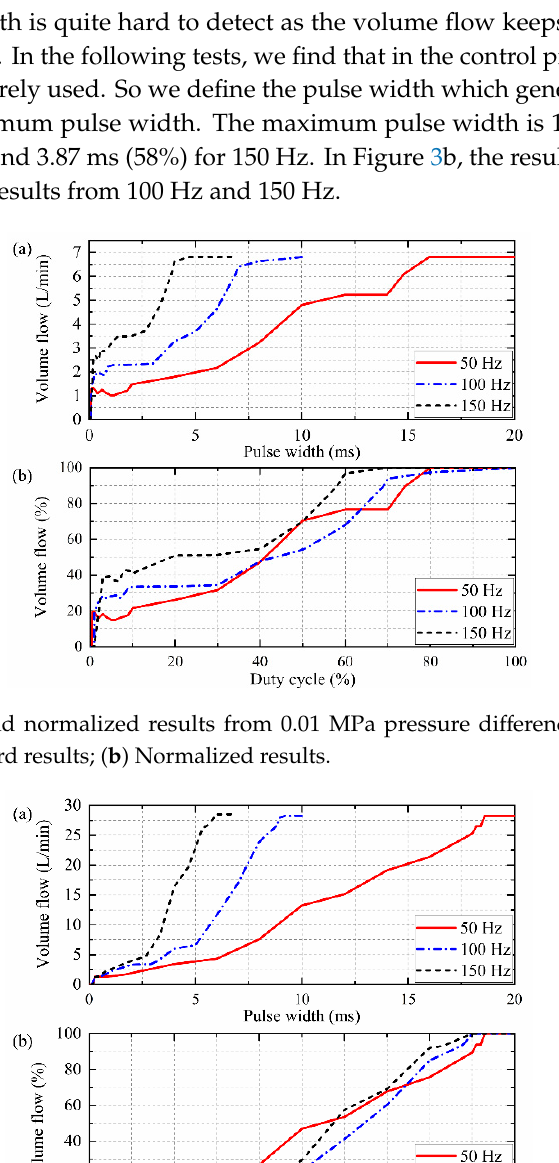
Figure 4. Standard and normalized results from 0.1 MPa pressure difference using three PWM frequencies: ( a ) Standard results; ( b ) Normalized results.